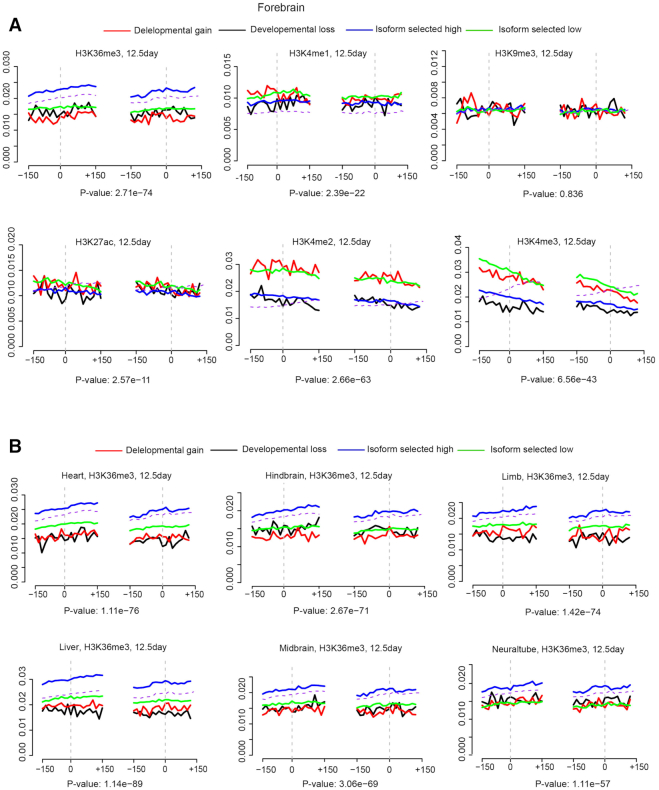
Representative distribution of mean ChIP-seq signal of 6 types of hPTM, including H3K36me3, H3K4me1, H3K9me3, H3K27ac, H3K4me2 and H3K4me3 on the flanking region (±150 bp) of four types of skipped exons. Dashed grey line shows exon–intron borders. (A) Forebrain, E12.5 (B) distribution of H3K36me3 among six tissues shows hPTM distribution was significantly different among different types of skipped exons (P-values, ANOVA test).